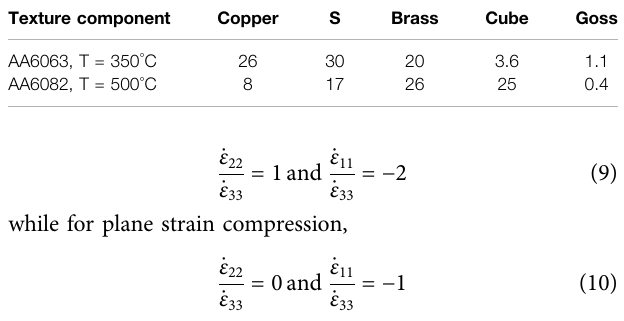
TABLE 2 | Intensity of the beta- fi ber texture components and Cube texture in the AA6063 and AA6082 alloys extruded at different temperatures. Texture